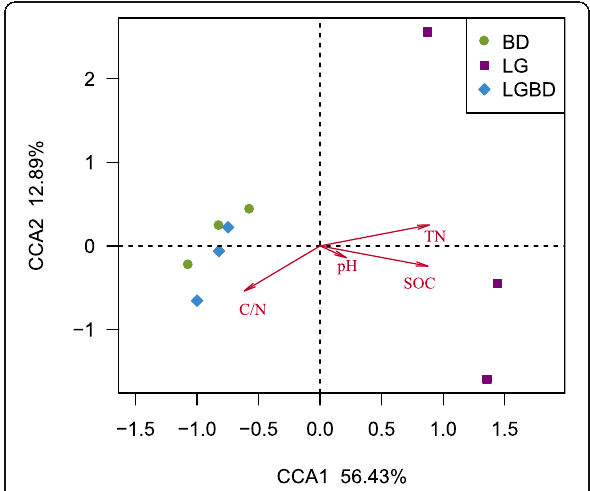
Fig. 5 Canonical correspondence analysis (CCA) ordination plots of the functional microbial community structure under different revegetation types. Note: SOC, soil organic carbon; TN, total nitrogen; C/N, soil carbon to nitrogen ratio. BD, Betula dahurica ; LG, Larix gmelinii ; LGBD, mixed Larix gmelinii and Betula dahurica